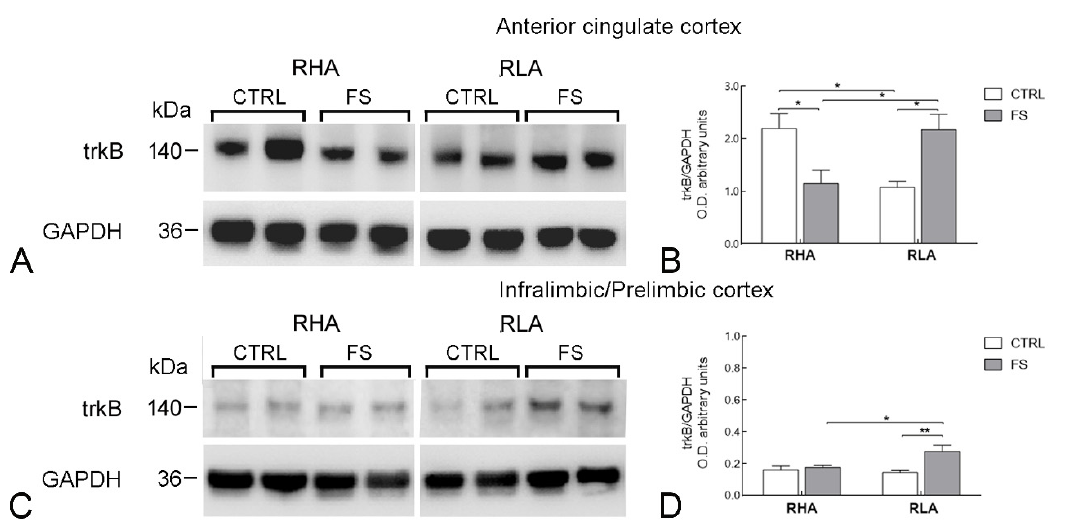
Figure 6. Western blot analysis of the trkB receptor protein levels in the anterior cingulate ( A , B ); and the infralimbic/prelimbic ( C , D ) regions of the medial prefrontal cortex of RHA and RLA rats under baseline conditions (CTRL) and after a 15 min session of forced swimming (FS). ( A , C ) shown are representative samples from two rats; and ( B , D ) densitometric analysis of the trkB/GAPDH band gray optical density (O.D.) ratios. Columns and bars denote the mean ± S.E.M. of eight rats in each experimental group. *: p < 0.05; **: p < 0.01 (Tukey’s post hoc test or Sidak’s correction for mul- tiple comparisons).